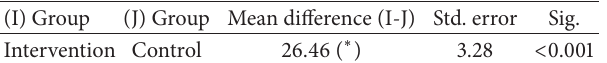
Table 5: Bonferroni post hoc test for comparison of two groups for self-care